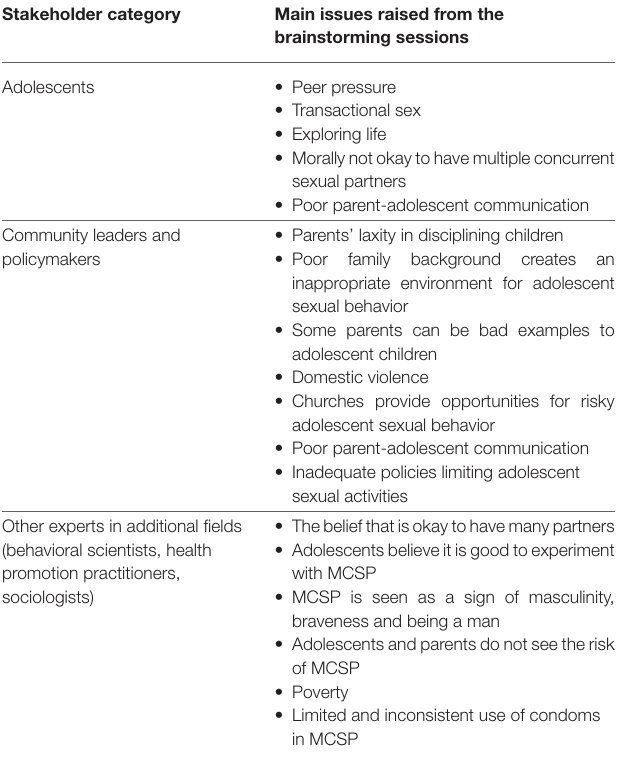
TABLE 1 | A summary of findings from brainstorming sessions on MCSP with stakeholders. Stakeholder